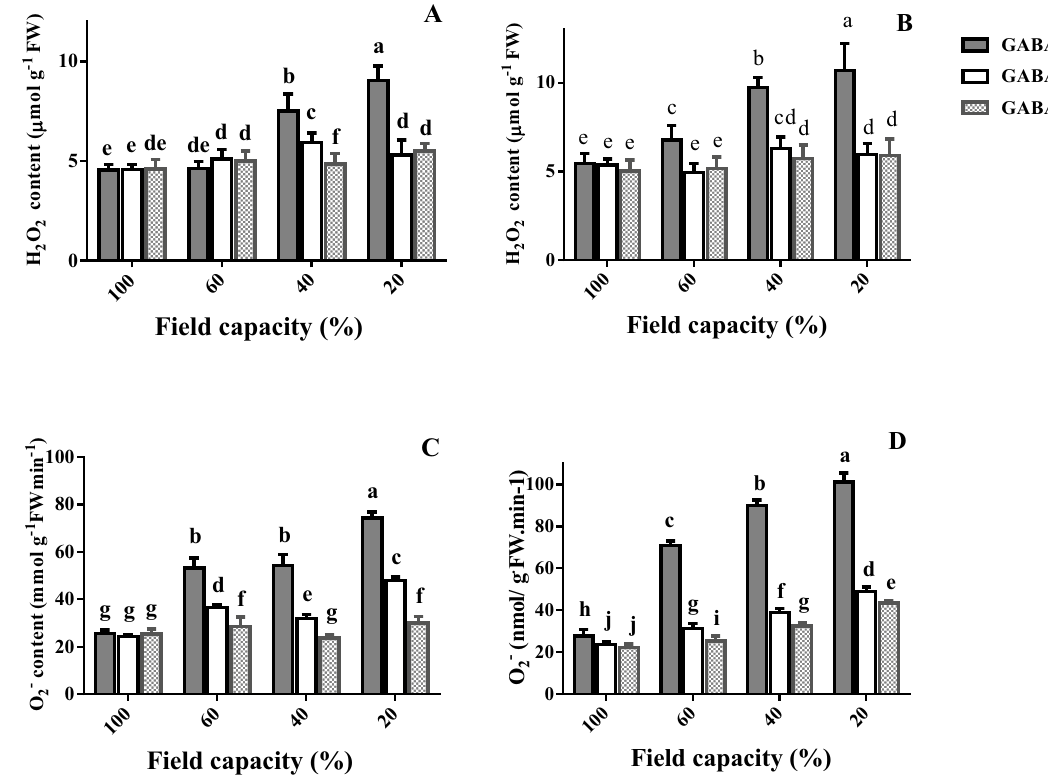
Figure 6. Leaf hydrogen peroxide (H 2 O 2 ; A , B ) and superoxide anion (O 2 − ; C , D ) content of cv. Arman (tolerant; left panels) and cv. Azad (sensitive; right panels) chickpea plants receiving exogenous application of γ-aminobutyric acid (GABA) at different concentrations (0, 25 and 50 μM) under different watering levels (100, 60, 40 and 20% field capacity) during cultivation. Within each insert, different letters indicate significant differences. Error bars indicate SEM (n = 3). FW fresh